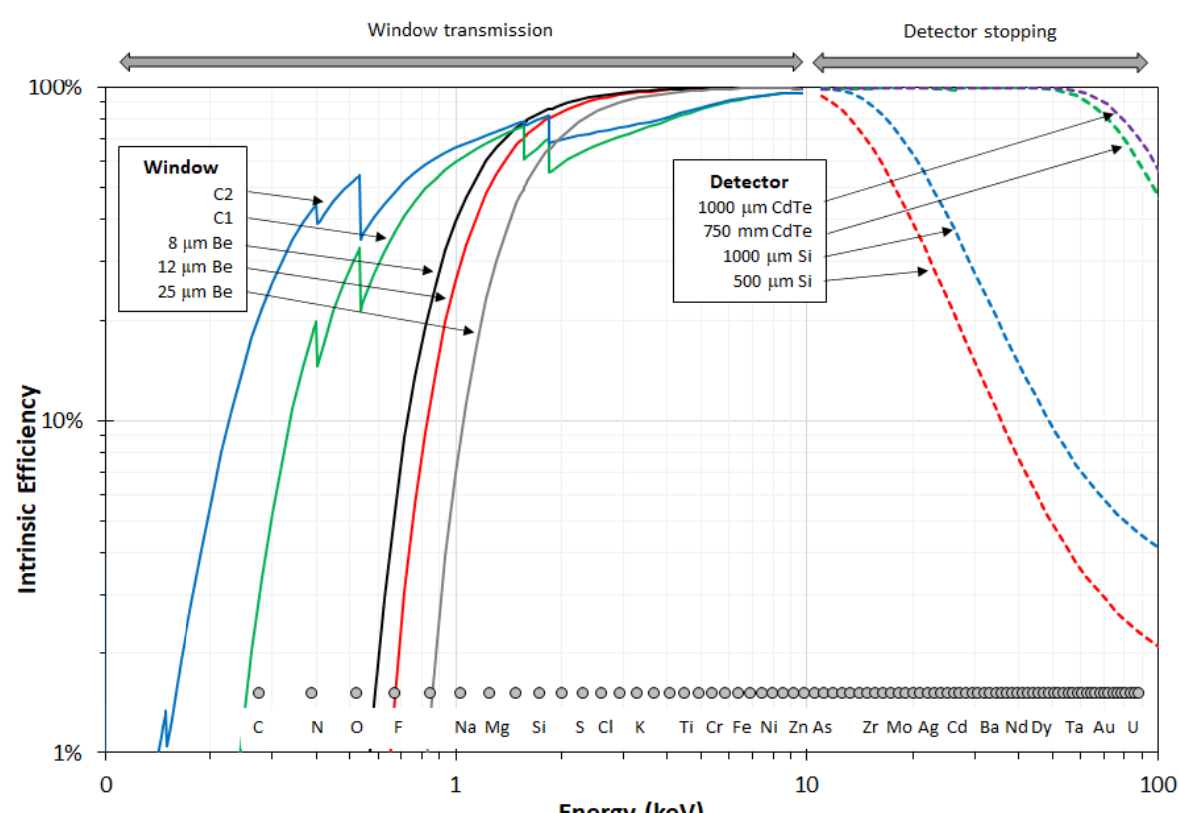
Figure 4. Comparison of the intrinsic efficiency of the X-123 detectors from Amptek. At low energies, the Be window limits sensitivity, and the 1 mm thick CdTe crystal (dashed violet curve) has a good efficiency up to 70 keV. © Amptek Inc 2021. Reprinted with permission.